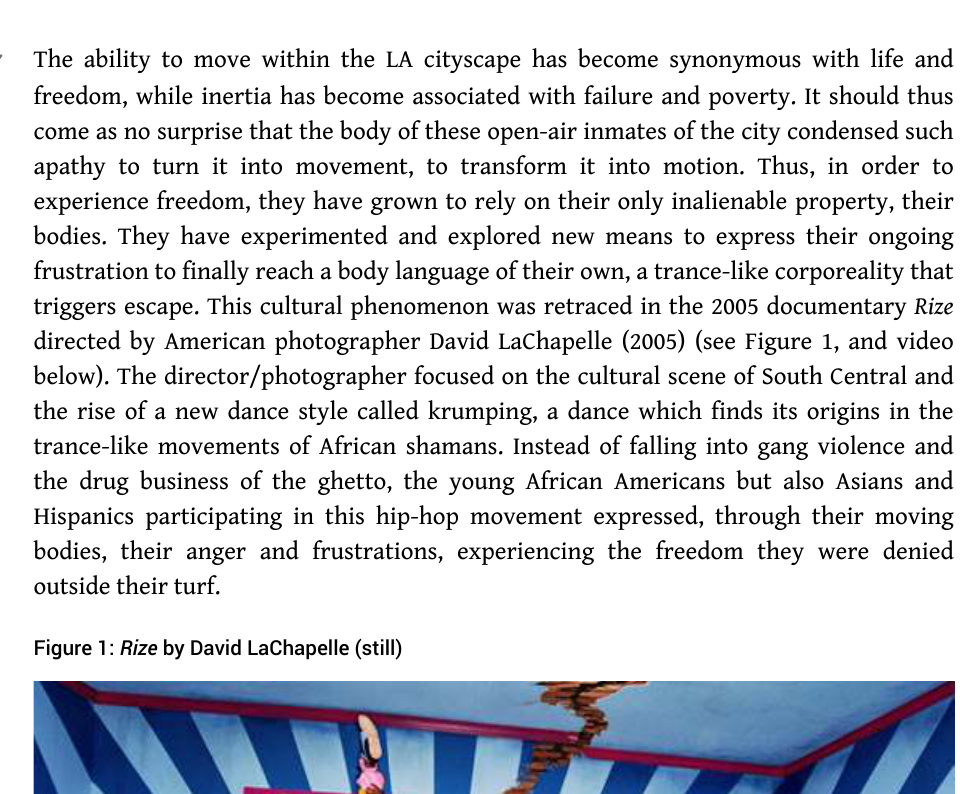
Figure 1: Rize by David LaChapelle (still)